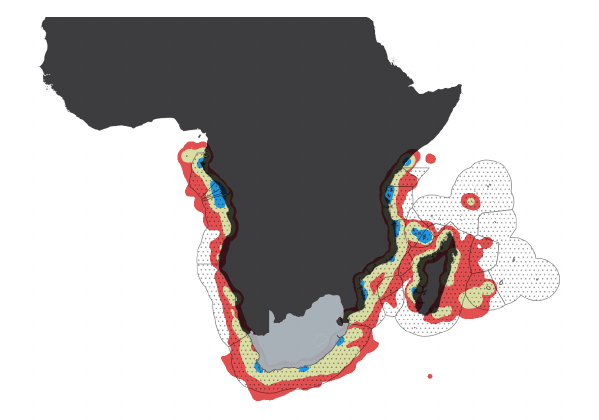
Figure 10. SAR Ship Detections in